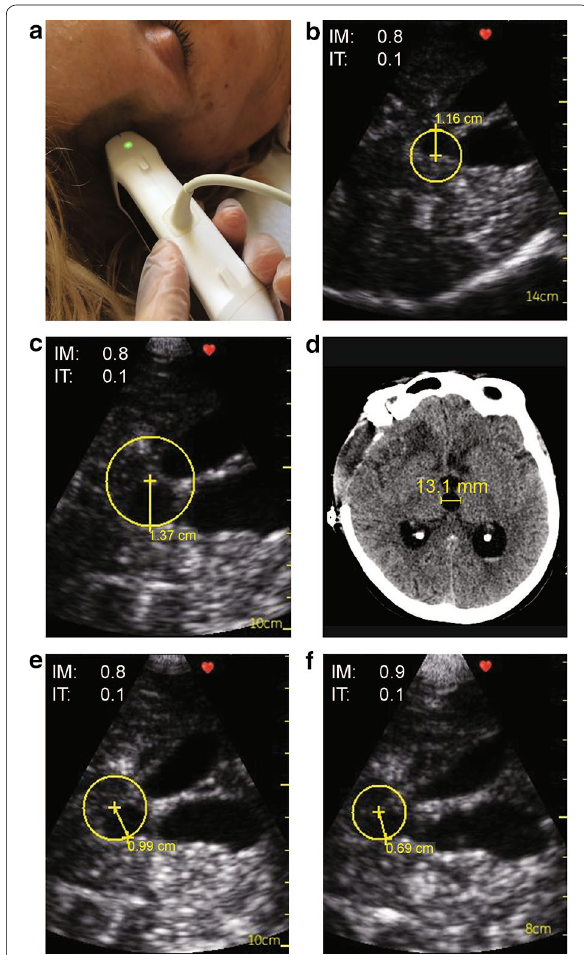
Fig. 1 a TCS using hand-held pocket ultrasound device (GE Vingmed Ultrasound AS, Horten, Norway). b Prior to EVD closure, TCS showed a measurement of the 3rd ventricle at around 1.16 cm. c On the third day, TCS showed a dilated 3rd ventricle measuring 1.37 cm. d CT scan showed a dilated 3rd ventricle measuring 13.1 mm. e Subsequently following EVD re-opening, on the next day using TCS the 3rd ventricle dimension was reduced to 0.99 cm. f The following day it went down to 0.69